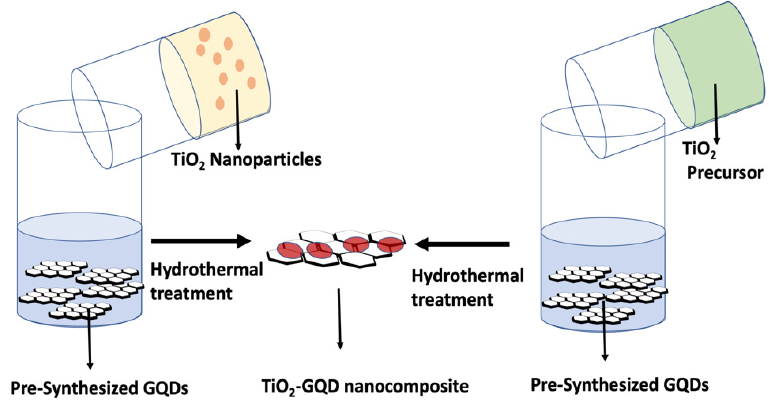
Figure 8. Schematics of TiO 2 -GQDs composite synthesis by hydrothermal